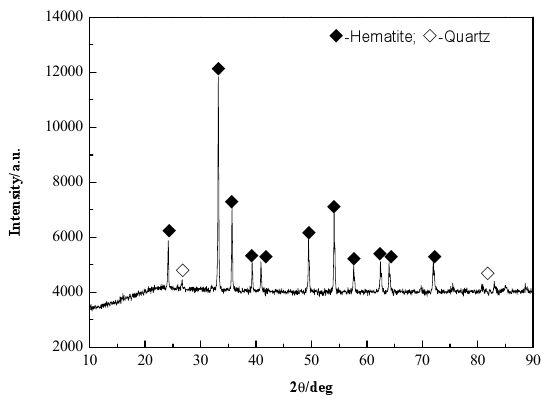
Figure 1. X-ray diffraction spectrogram of the pure hematite powder.